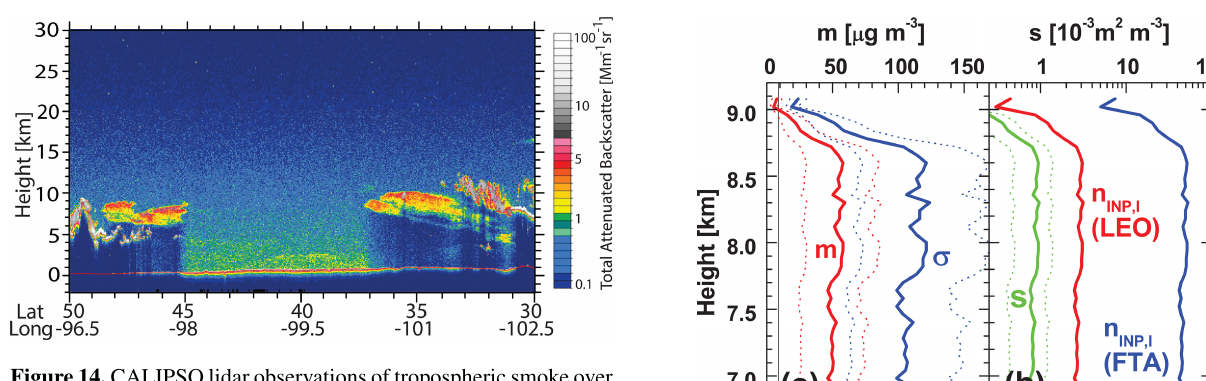
Figure 14. CALIPSO lidar observations of tropospheric smoke over North and South Dakota (45–48.5 ◦ N, 7–9km height) and over Texas (33–37 ◦ N, 8–10km height) on 13 September 2020, around 9:15UTC (CALIPSO, 2020a). The smoke layers (in yellow to red) originated from British Columbia (North and South Dakota plume, travel time of 24h) and from California (Texas plume, 2–5d of travel time) as HYSPLIT backward trajectories indicate (HYSPLIT, 2020).